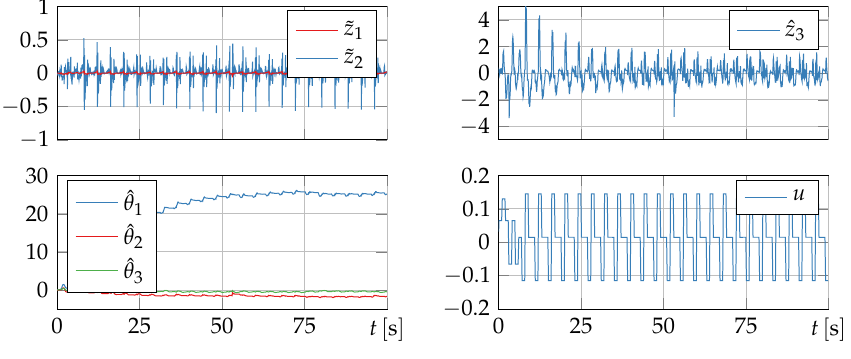
Figure 11. Results of the experiment.